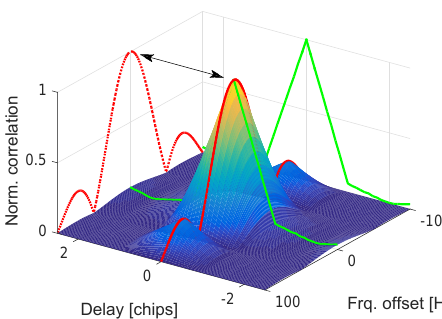
Figure 10. Normalised C/A code correlation function as a function of delay and Doppler frequency offset. At zero delay the code cor- relation function corresponds to the frequency response (solid red line). It closely matches the modulus of the normalised sinc func- tion (dotted red line, shifted by + 2 . 5 chips for